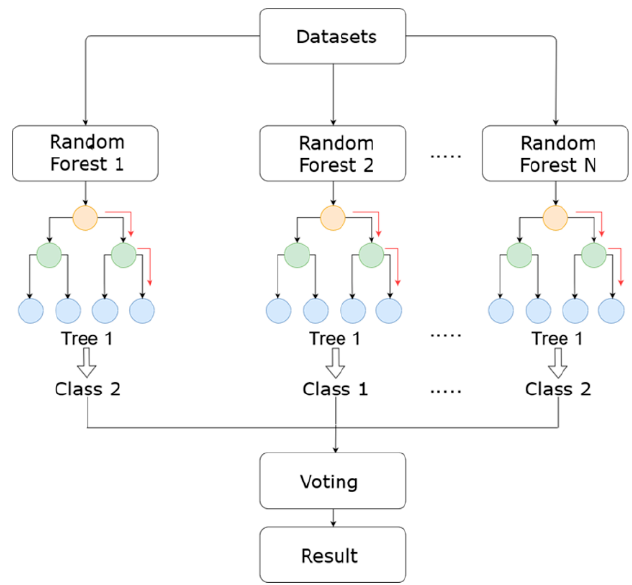
Figure 1. Random forest example scheme.